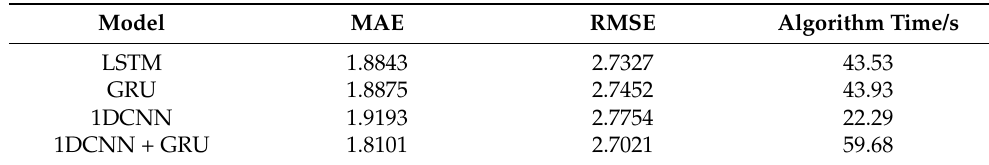
Table 3. Toll station 17 model comparison